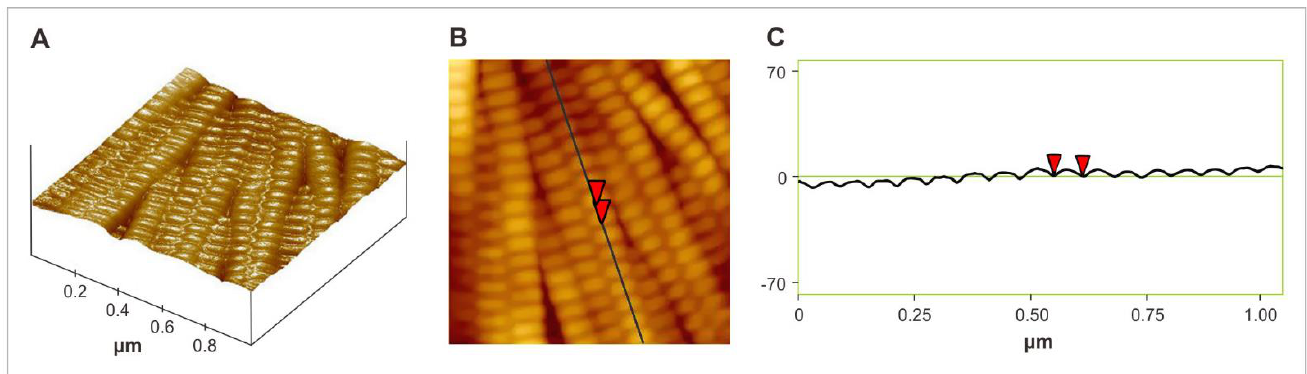
Figure 1. ADM image obtained with atomic force microscopy (native material): ( A ) 3D image of ADM; ( B ) “Height” image of ADM; ( C ) topography of the collagen fiber of the ADM according to the profile marked in Figure 1 B (native material).